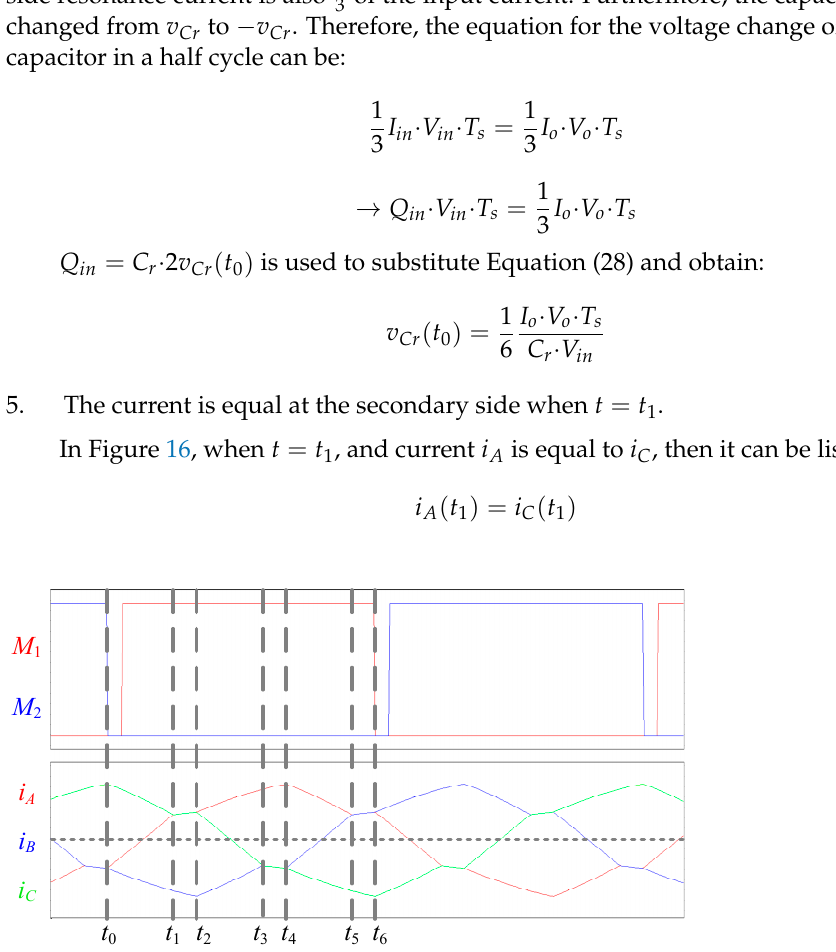
Figure 16. Waveform of transformer current.